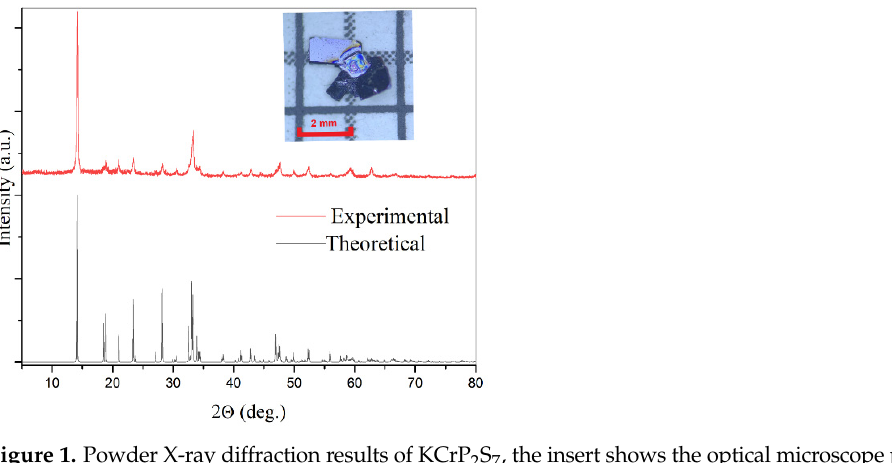
Figure 1. Powder X-ray diffraction results of KCrP 2 S 7 , the insert shows the optical microscope photo of selected KCrP 2 S 7 crystals. The crystals were manually cut and selected for properties measurements.